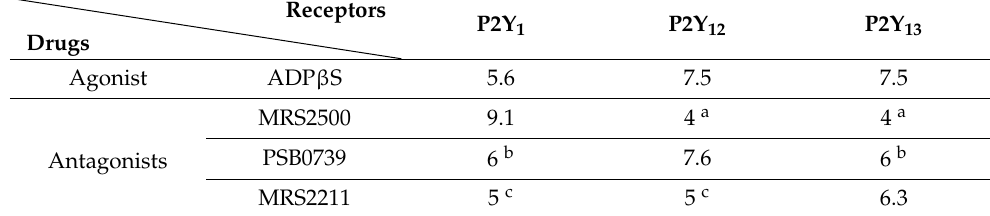
Table 3. Affinity values of some P2Y ligands for P2Y 1 , P2Y 12 and P2Y 13 receptors. Drugs